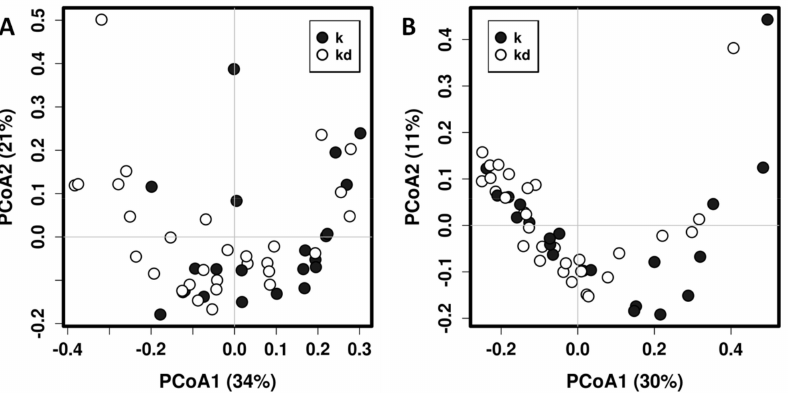
Figure 1. Principal coordinates analysis (PCoA) using weighted ( A ) and unweighted ( B ) UniFrac distance matrix of fecal microbiota of children with dog (kd) and without dog (k).